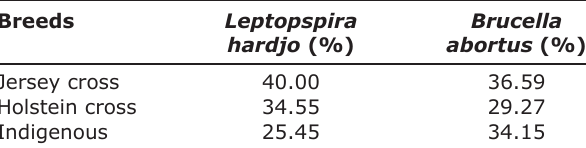
Table-2: Breed - wise incidence of Leptospira and Brucella in